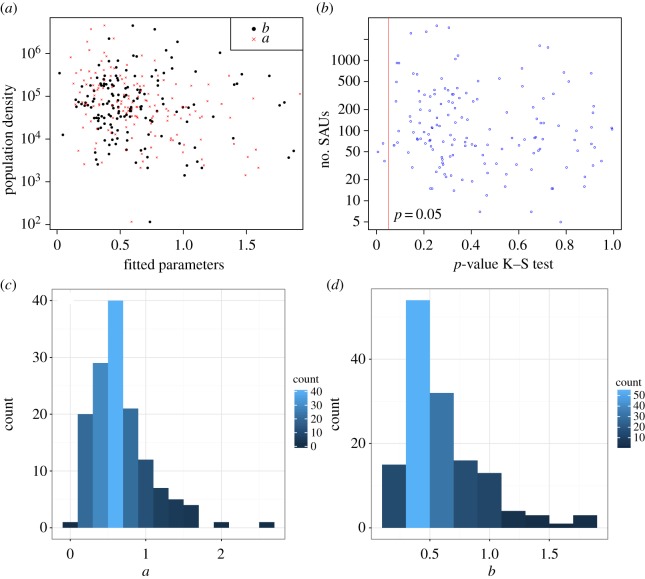
Fitted parameters, sample sizes, population density and goodness of fit. (a) shows on a semi-logarithmic scale the fitted parameters versus population density for the 150 countries and territories we analysed. (b) is a semi-logarithmic plot of the p-value for the K–S test versus the number of SAUs for the 150 countries; left of the red line is the rejection zone (p<0.05). (c) and (d) are histograms of the fitted a and b values for the 141 selected countries.